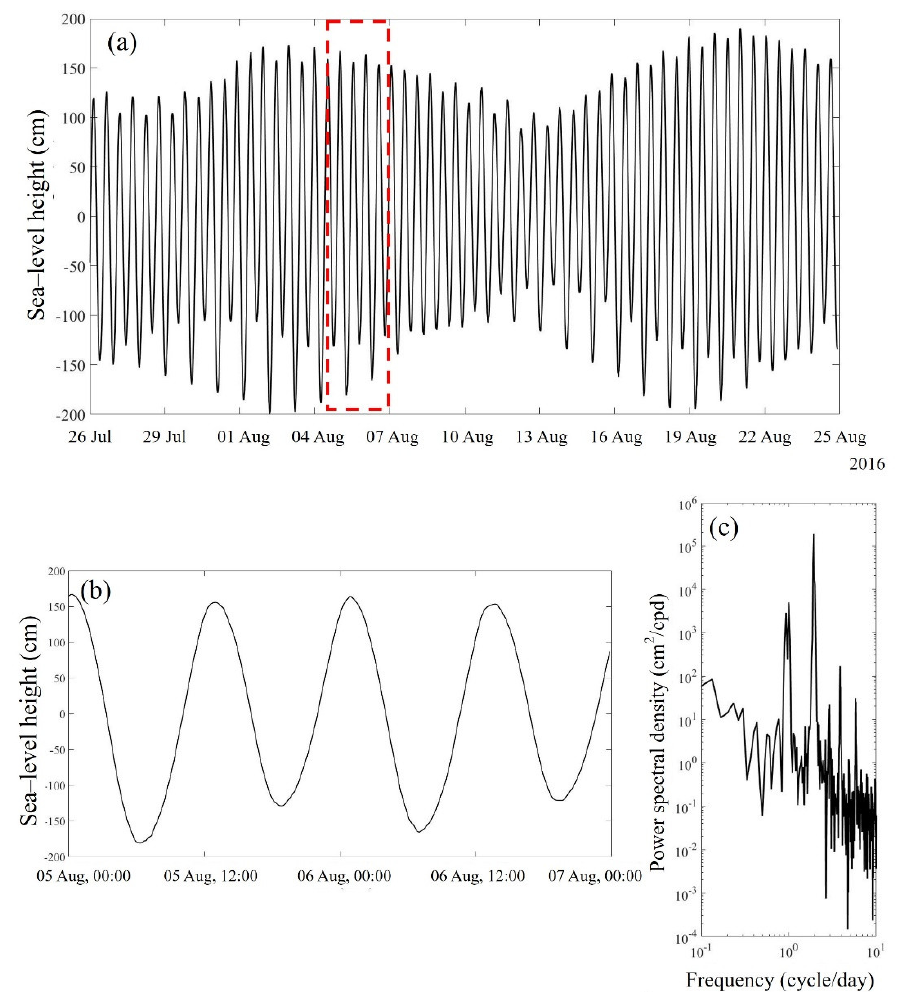
Figure 5. ( a ) Sea-level time series at the tide gauge station shows the extensive tide range in the region. ( b ) The close-up of sea-level time series (red dashed frame) shows the extensive tidal range in the region. ( c ) Power spectra of the sea level at tide gauge station. Frequency is presented using the unit of cycles per day.